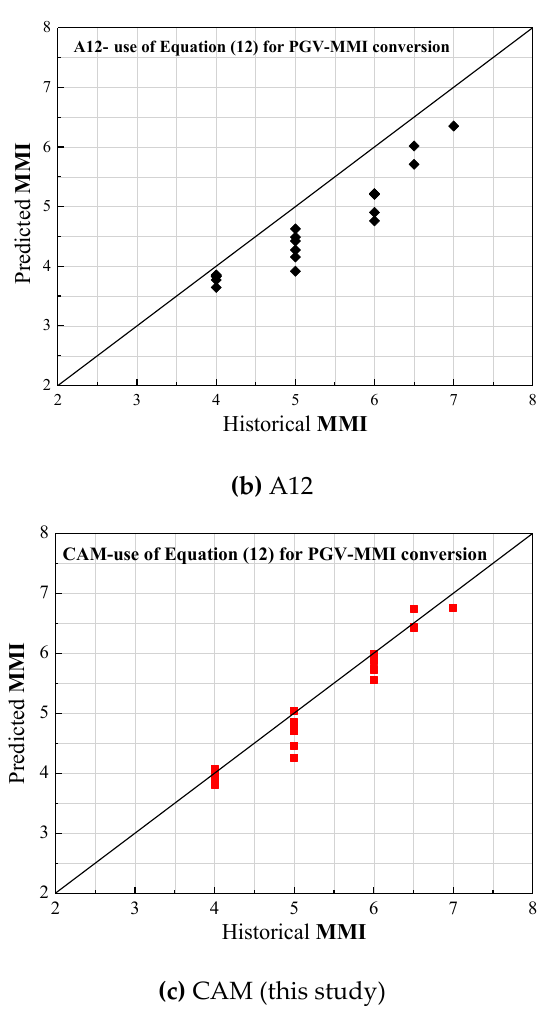
Figure 10. Comparison between historical recorded and model-predicted modified Mercalli intensity (MMI) for SEA.